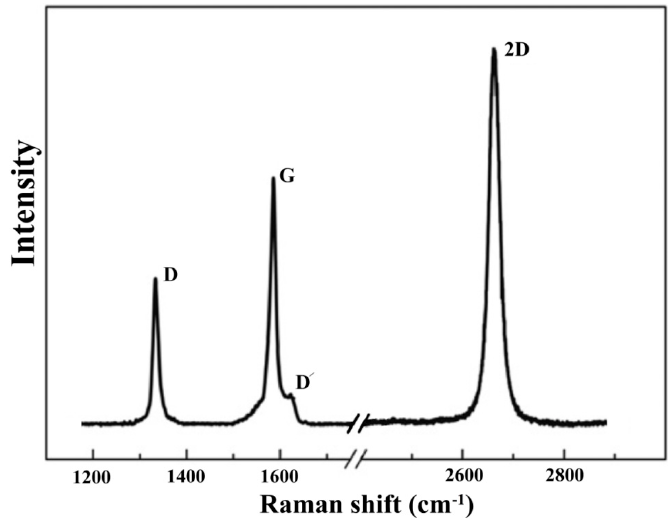
Figure 4. Main Raman peaks: D, G and 2D bands of graphene layer.